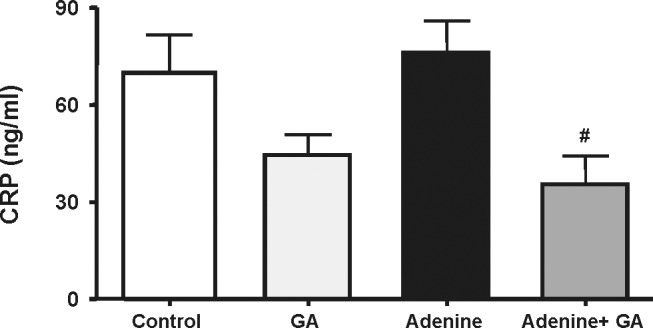
Plasma C-reactive protein concentration in control rats, rats treated with gum arabic (15% w/v in drinking water) and rats treated with adenine (0.75% w/w) alone in feed, or with adenine and gum arabic given concomitantly at the same dose for 28 days.Each column and vertical bar represents the mean ± SEM (n = 6). # p≤0.05 vs. adenine treatment.